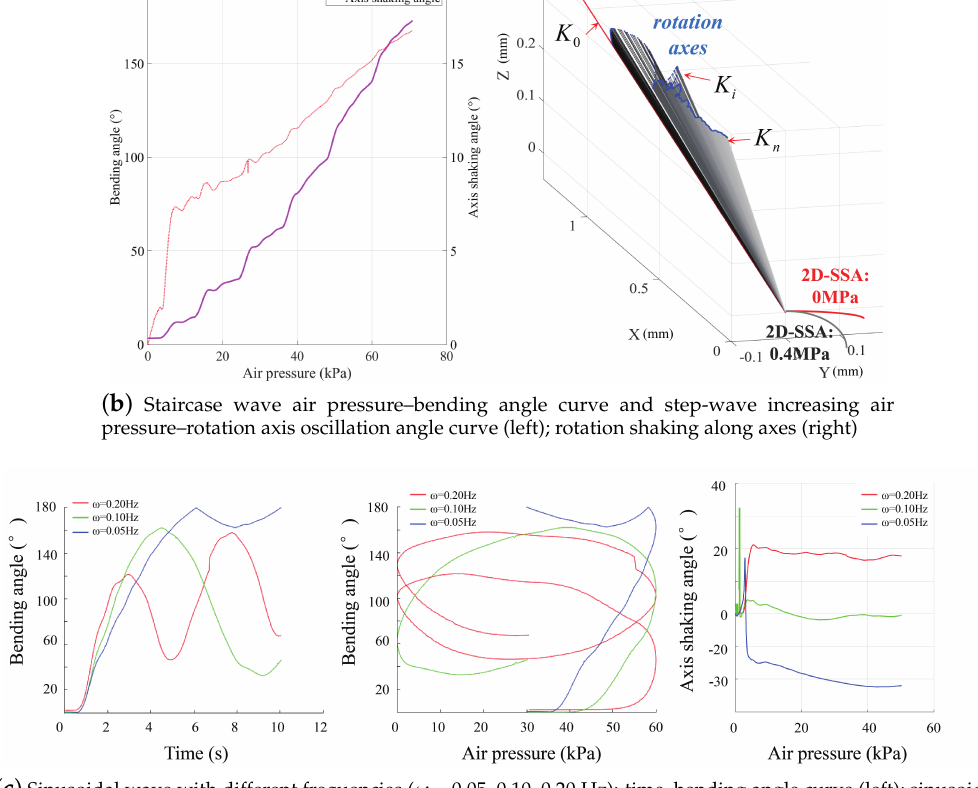
Figure 9. Setup for measurement of the bending angle using a laser tracker and IMU